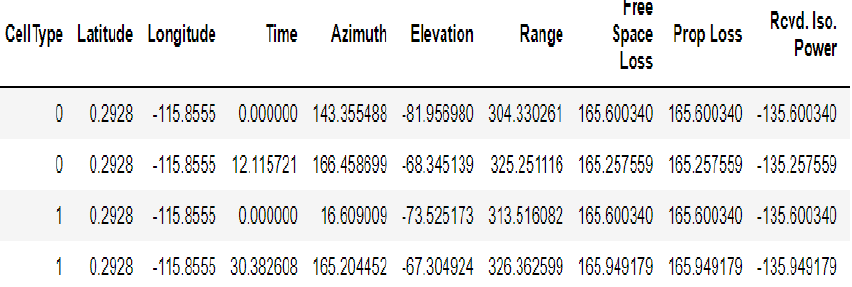
Figure 5. User Equipment Data Sample